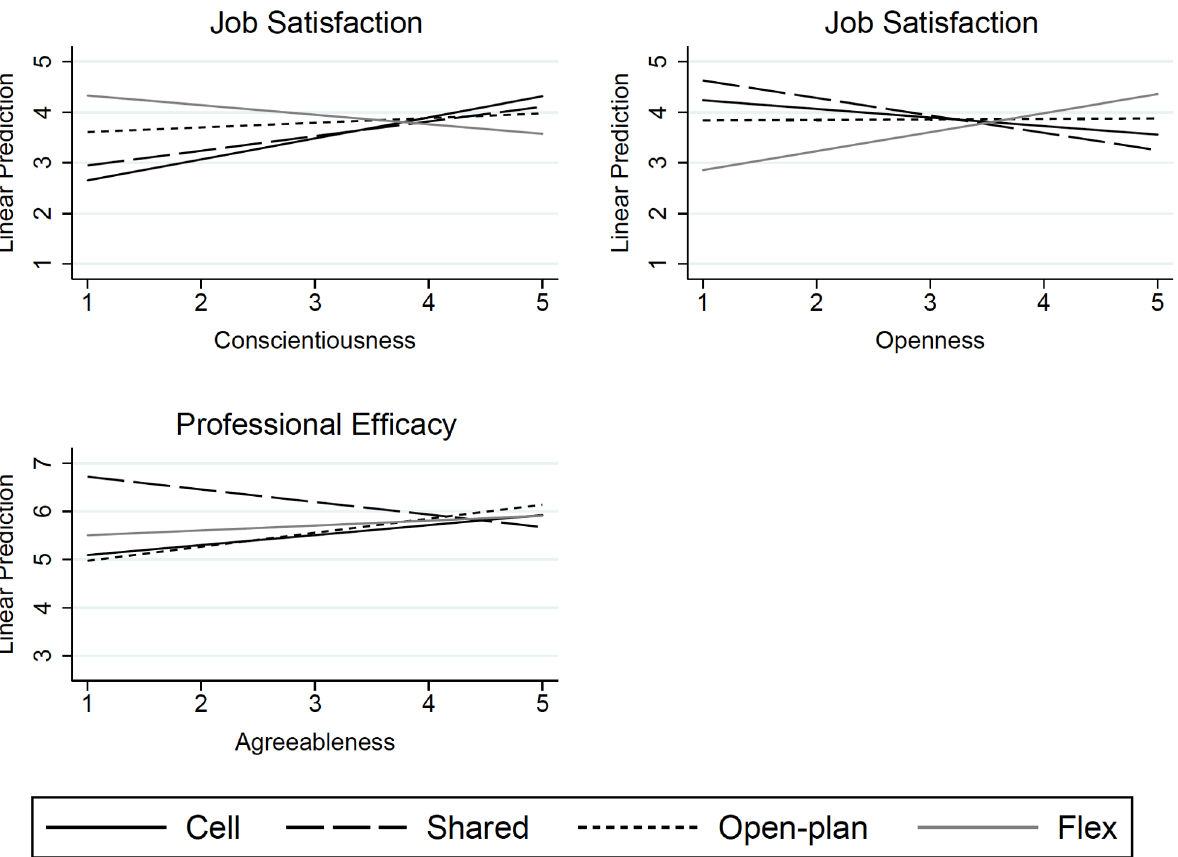
Fig 2. Adjusted predictions of office type upon job satisfaction and professional efficacy in relation to selected personality traits in 1205 Swedish public and private sector worker.